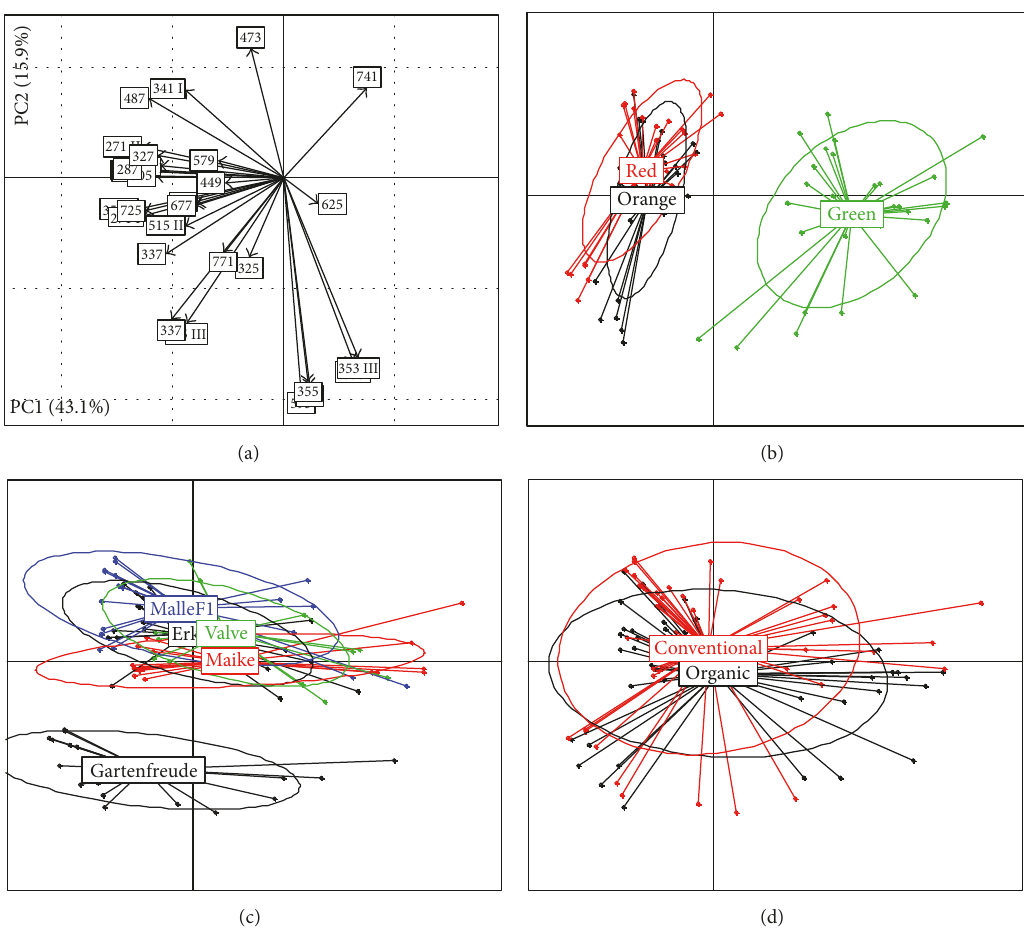
Figure 1: Results of PCA: (a) factor loadings of studied compounds concerning the first two principal components covering 59.0% of variability in total (numbers in figure present the m/z values and are explained in Table 1); ((b), (c), and (d)) factor scores grouped by ripening stage, cultivars, and cultivation mode, respectively (group label represents the group